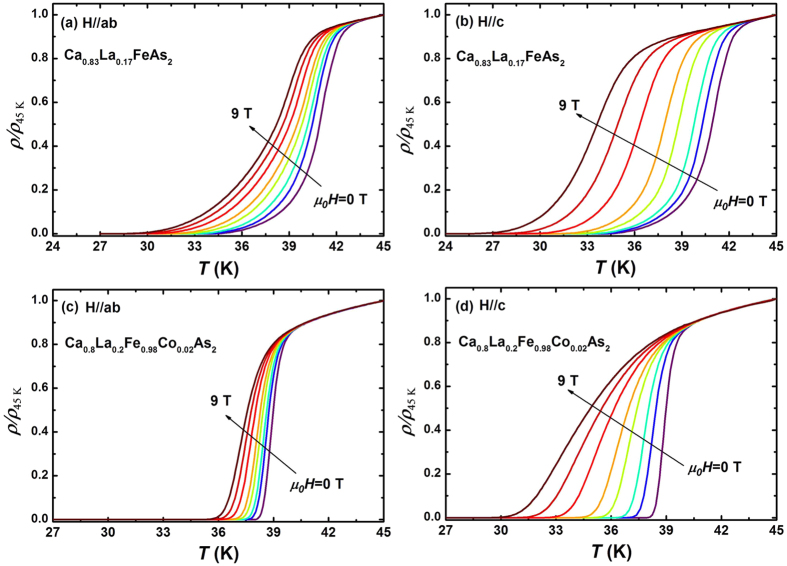
Temperature dependence of in-plane resistivity (nomalized to 45 K) of Ca0.83La0.17FeAs2 for (a) H//ab and (b) H//c, and of Ca0.8La0.2Fe0.98Co0.02As2 for (c) H//ab and (d) H//c at the various magnetic fields from 0 to 9 T(0, 0.5, 1, 2, 3, 5, 7 and 9 T).